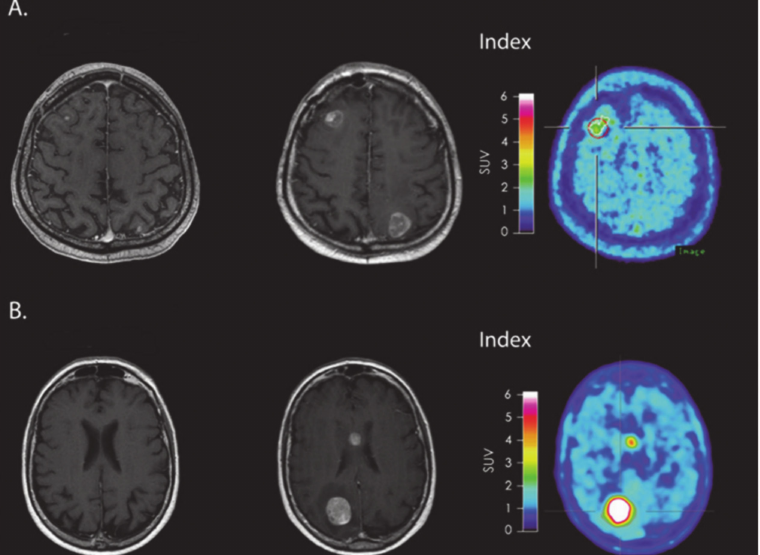
Figure 7. ( A ) MRI and FET-PET images of a patient with melanoma brain metastasis, diagnosed with PsP using immune-related response criteria (irRC) after receiving immune checkpoint inhibitor immunotherapy. The index MRI shows >25% increase in contrast-enhancing lesions located in frontal and occipital regions. Low metabolic tumor activity was observed on FET-PET images. ( B ) MRI and FET-PET images of a patient with melanoma brain metastasis, who was diagnosed with TP using irRC. The index MRI shows >25% increase in contrast-enhancing lesions located in the body of corpus callosum and occipital regions. A very high metabolic tumor activity was observed on FET-PET images. Reprinted with permission from ref. [109]. Copyright 2016 Oxford University